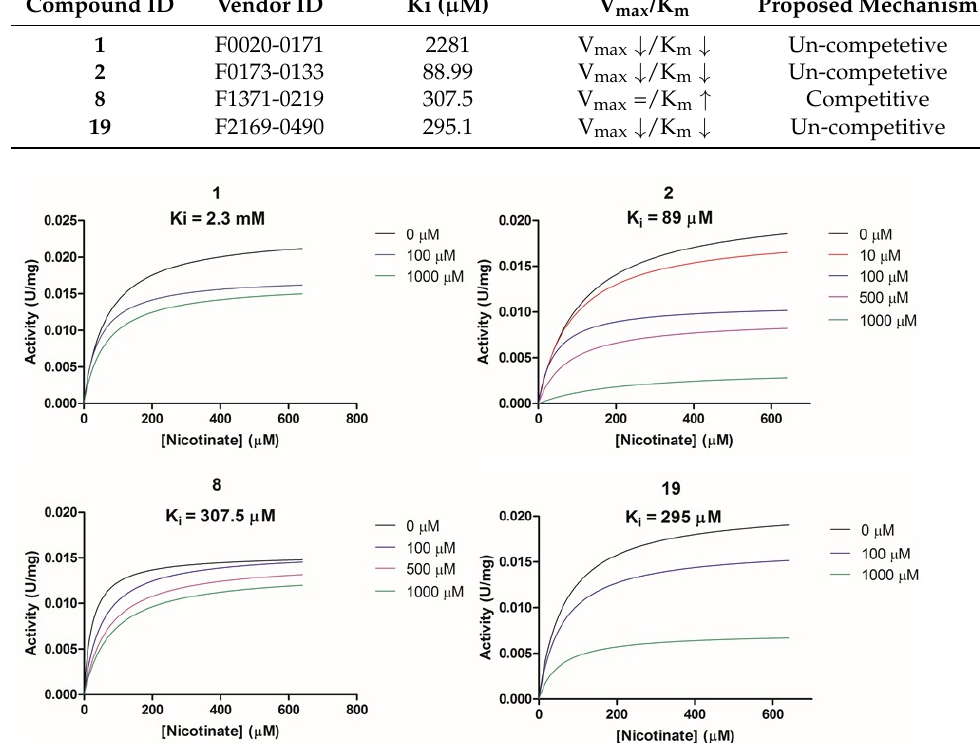
Figure 7. Analysis of NAPRT enzyme activity in the presence or absence of putative NAPRT inhibitors. Graphs represent Michaelis–Menten regression curves of NAPRT reactions performed in the presence of different concentrations of compounds 1 , 2 , 8 , and 19 . The concentration-dependent inhibiting effect on the NAPRT reaction is represented with different colors.